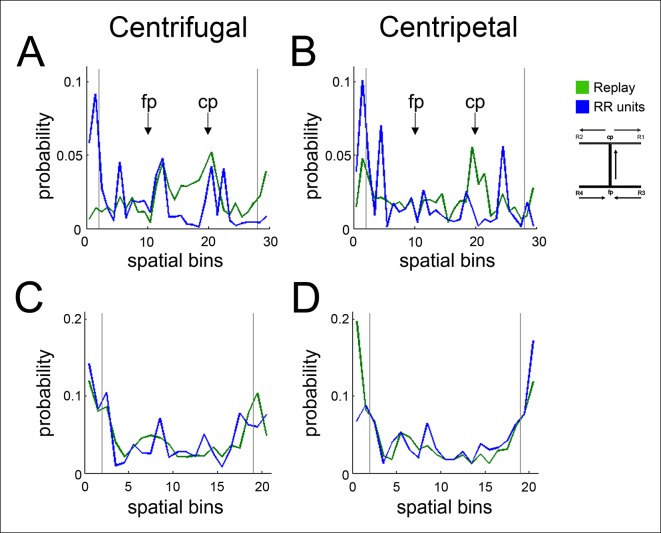
Centrifugal and centripetal replayed locations associated with RR unit activity on the SWM task and the linear track.(A) On the SWM task, the distribution of centrifugal replayed locations (green) is less concentrated at reward sites (marked by vertical lines) than the distribution of RR unit-associated centrifugal replayed locations (blue). See Figure 5 for statistics. Maze segments were aggregated by apposing them in the direction of run in the choice direction: from force reward sites (R3, R4) to force point (fp) to choice point (cp) to choice reward sites (R1, R2). Spatial bins 1–10 show the average of the force arms of the task (arms 3 and 4), spatial bins 11–20 show the central arm, and spatial bins 21–30 show the average of the choice arms (arms 1 and 2). (B) The distribution of centripetal replayed locations (green) on the SWM task is similar to the distribution of RR unit-associated centripetal replayed locations (blue). (C) On the linear track, the distributions of centrifugal replayed locations (green) and RR unit-associated centrifugal replayed locations (blue) are similar. (D) On the linear track, the distribution of centripetal replayed locations (green) and the distribution of RR unit-associated centripetal replayed locations (blue) are also similar.